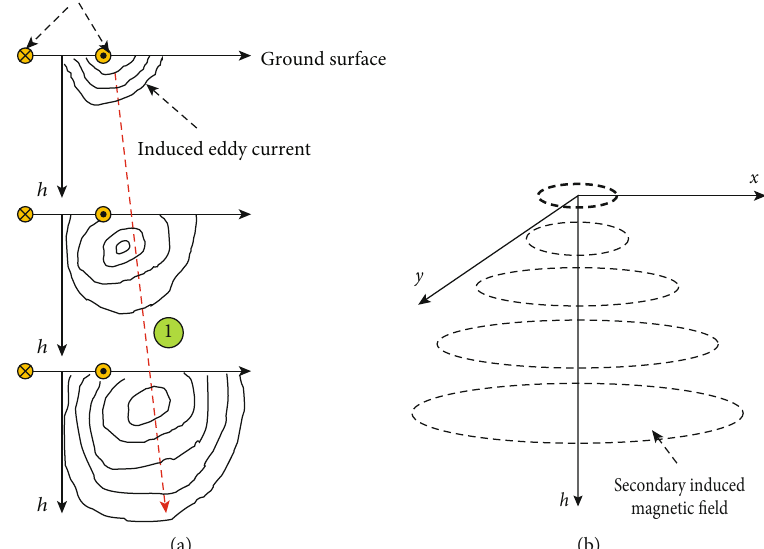
Figure 1: Sketch map of the basic principle of TEM. h : formation depth; ① : the induced eddy current with larger and larger di ff usion range and smaller and smaller intensity.